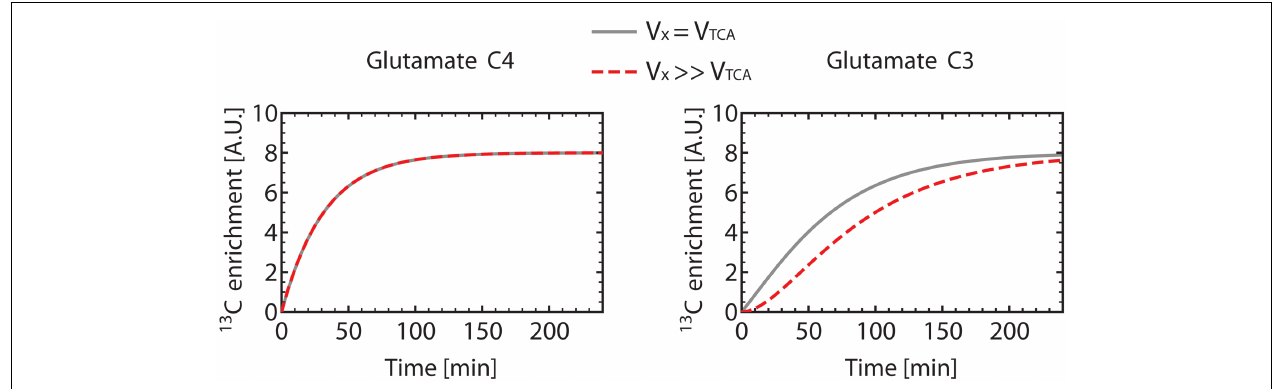
with the same value for V gt .This results in a sigmoidal-shaped glutamate C3 turnover curve, while the glutamate C4 curve remains unchanged.This observation illustrates the necessity to measure the C3 turnover curve to determine both V X and V TCA . In these simulations, dilution at the level of glutamate was not included, resulting in the same enrichment level for C4 and C3 at